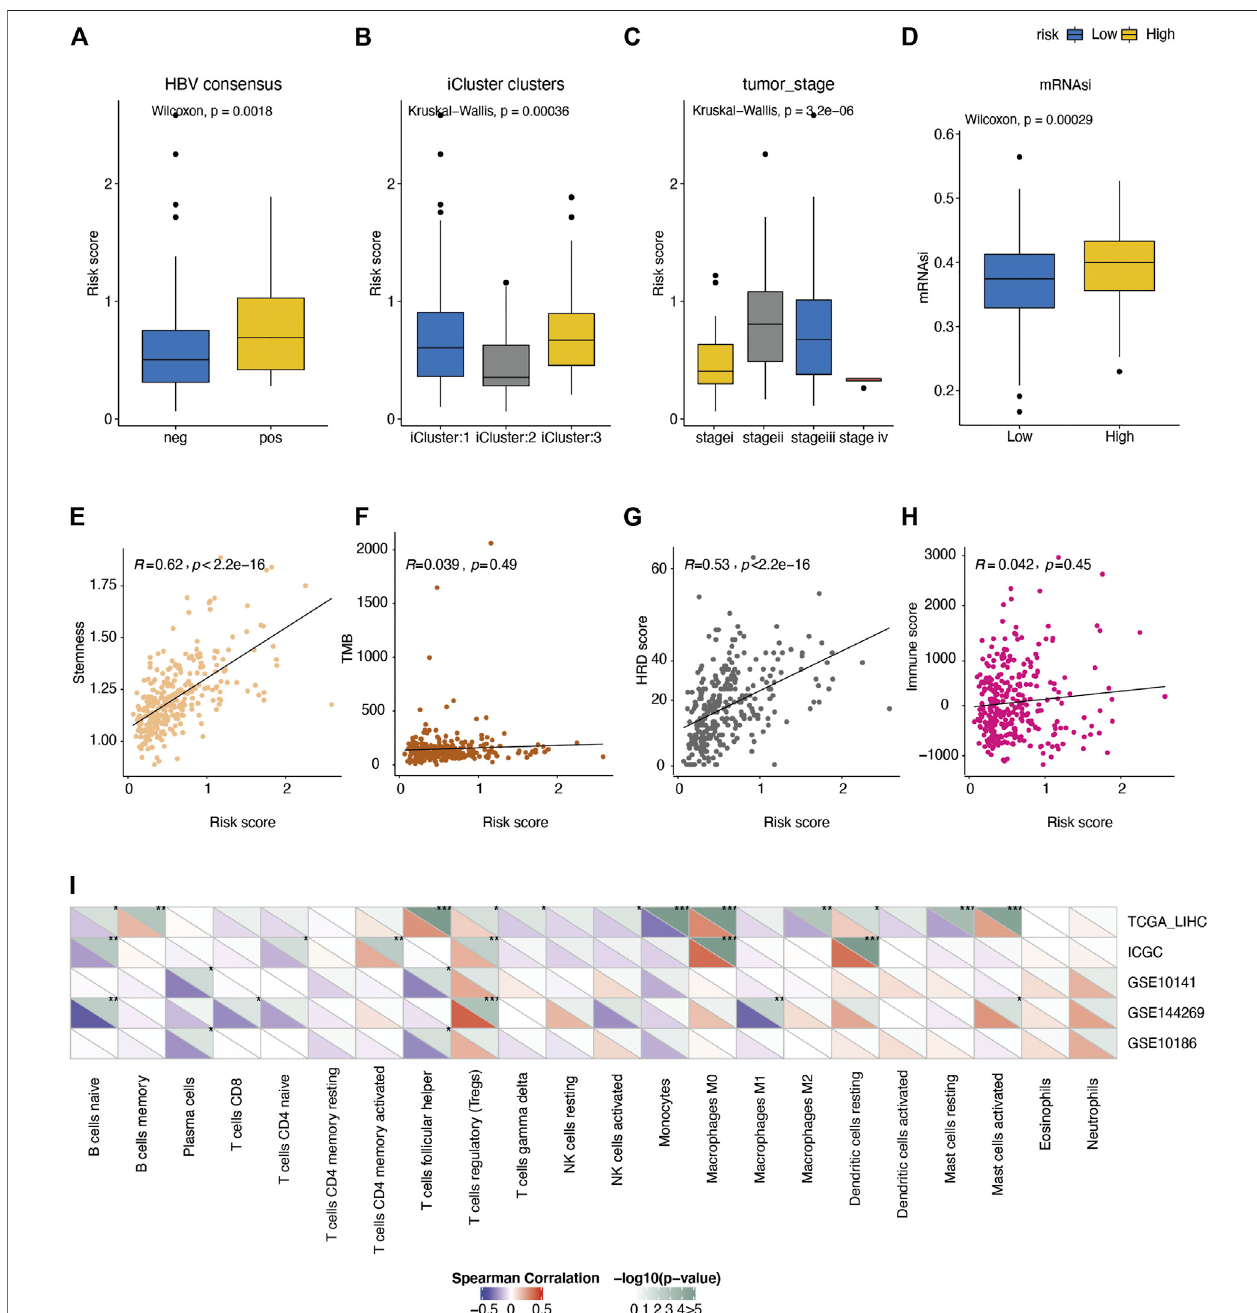
FIGURE4| Comparisonofthemolecularfeaturesbetweendifferentriskgroups.Distributionofriskscoreunderthestatusof (A) HBVinfection, (B) TCGAmolecular typing, (C) tumorstage. (D) Comparisonofthetumorstemnessscore(mRNAsi)betweenhigh/low-riskgroups. (E-H) Spearmancorrelationoftheriskscorewith I tumor stemness score, (F) mutation burden, (G) HRD score, and (H) immune score. (I) Spearman correlation of risk score with fractions of 22 immune cell types in fi ve liver cancer cohorts.